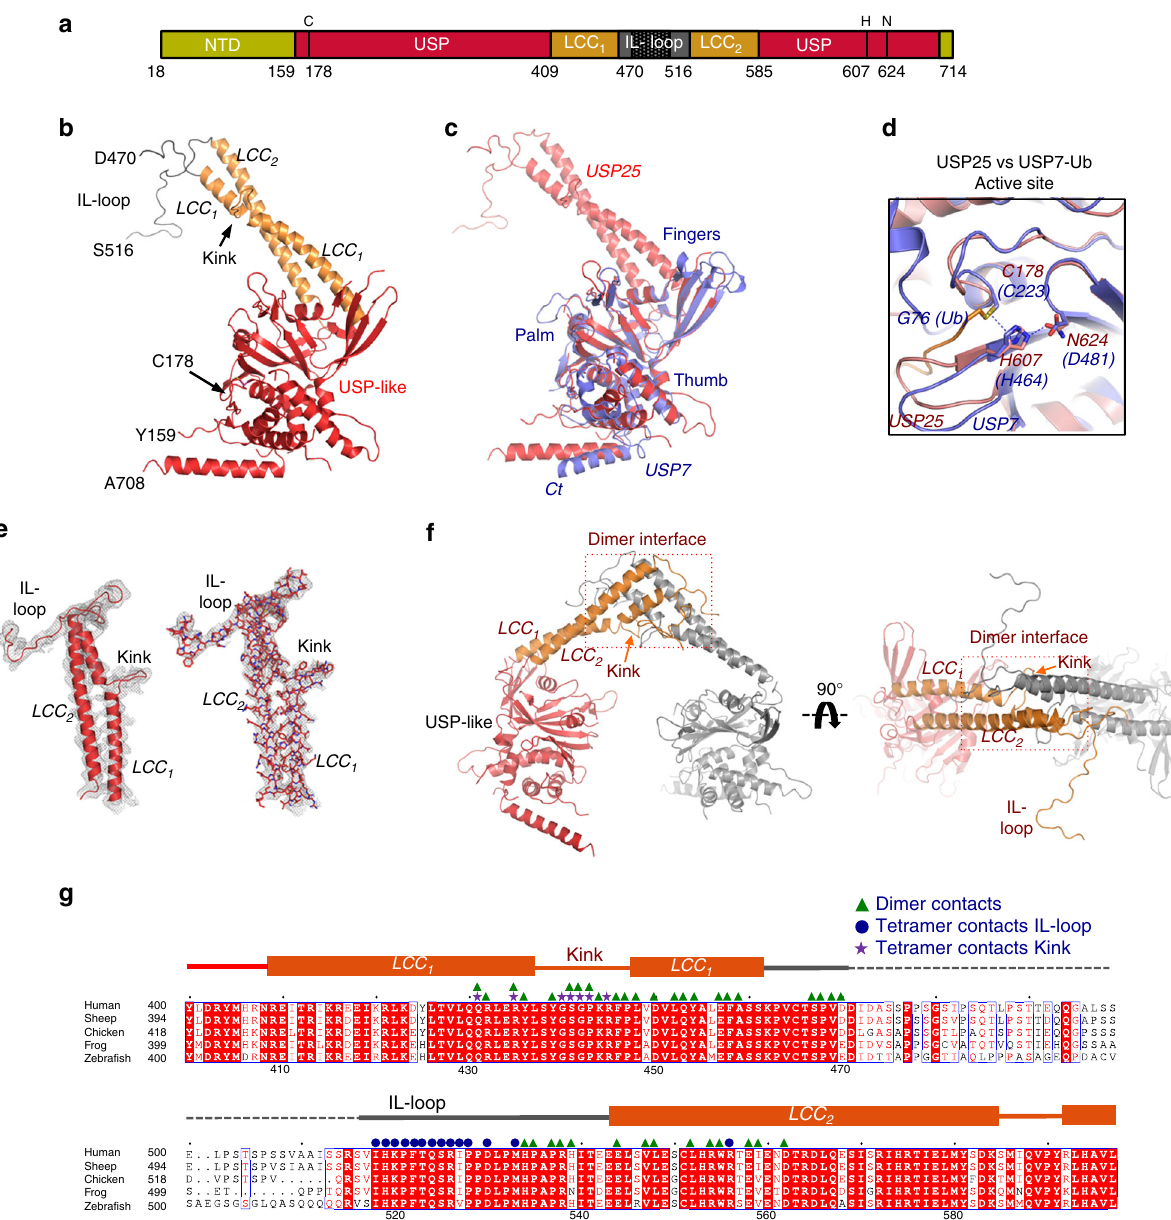
Fig. 2 The crystal structure of USP25. a Scheme of the domain composition of the crystal USP25 construct. N-terminal domain (NTD) (18 – 158), and the non-conserved sequence (dashed gray color, 471 – 515) of inhibitory loop (IL-loop) are not observed in the fi nal structure. b Ribbon representation of the different domains of the USP25 monomer. Red color shows the conserved USP-like domain, orange color the coiled-coil domain (LCC), and black color the domain IL-loop. Active site cysteine and domain boundaries are labeled. c Structural superposition between USP25 (red) and USP7 (blue) structures (PDB code 5JTJ). Palm-like domains are labeled. d Close-up view of the superimposition of active sites of USP25 and USP7. USP25 and USP7-ubiquitin aldehyde are shown in orange and blue, respectively. Catalytic triad residues from USP25 are labeled and shown in stick representation, whereas the corresponding residues from USP7 are shown within parentheses. Hydrogen bonds are represented by dashed lines. e Two representations of the electron density maps of the LLC and IL-loop domains of USP25. f Ribbon representation of the two monomers composing the dimer structure observed in the crystal of USP25 in two different orientations. g Sequence alignment of the LCC-IL-loop domain of USP25 across species. Green triangles indicate contacts in the dimer interface. Blue circles and purple stars indicate tetramer contacts by the IL-loop or the Kink region, respectively. All sequences are aligned online with Clustal Omega and formatted using ESPript